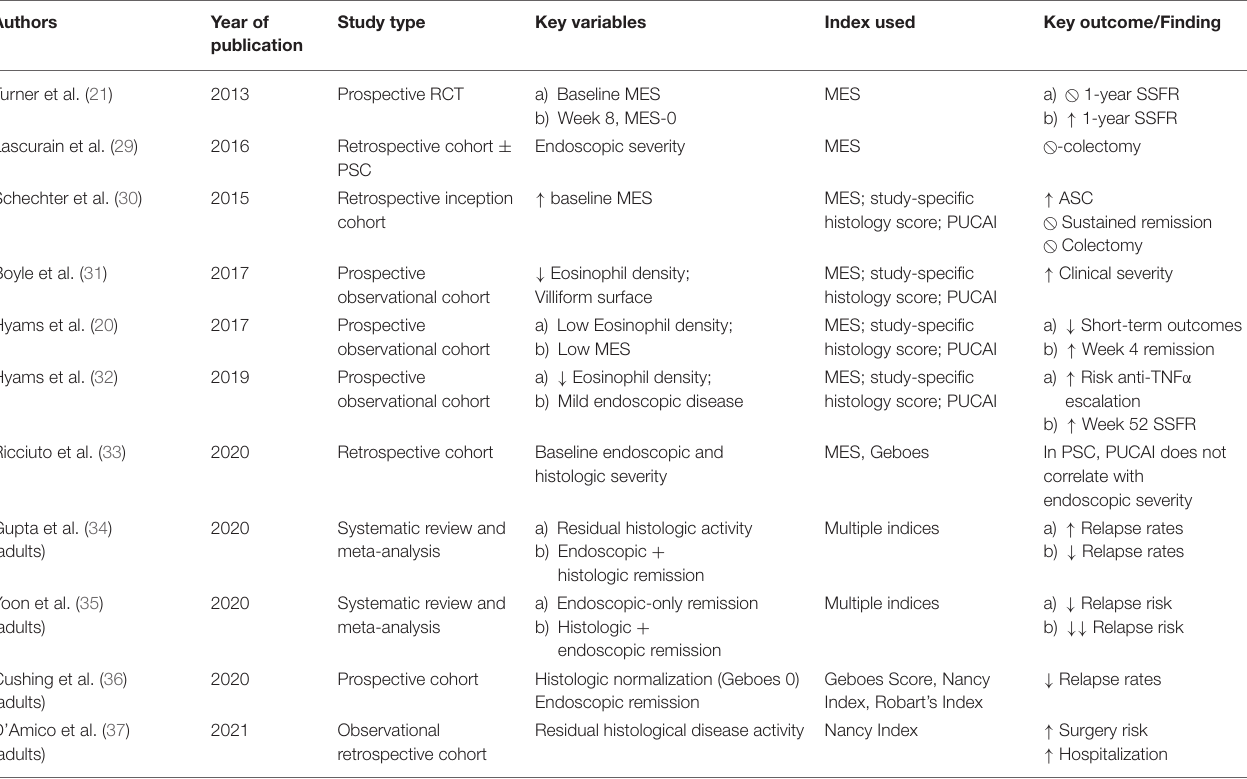
TABLE 1 | Outcome associations of endoscopic and histologic